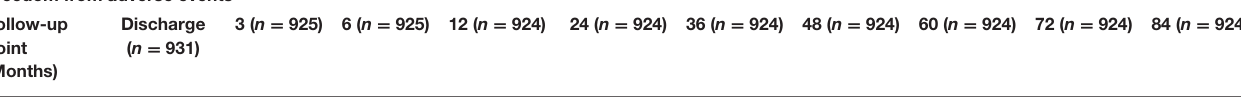
TABLE 3 | Summary of event-free survival rates at pre-set follow-up points. Freedom from adverse events